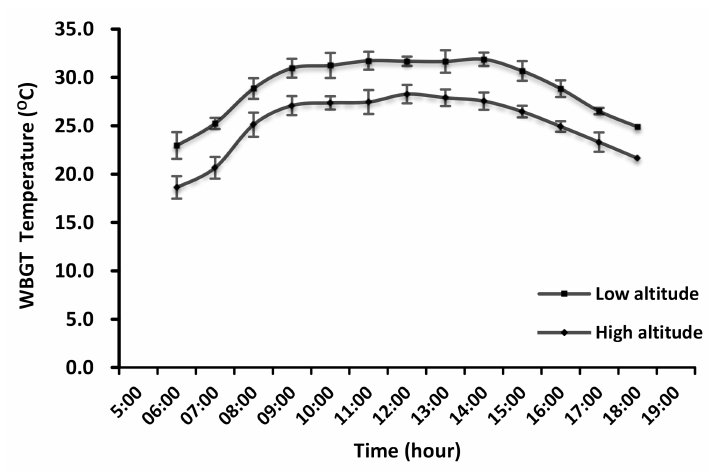
Figure 1. Average WBGT (Wet Bulb Globe Temperature) hourly measurements in a low-altitude area (Karawang Regency) and a high-altitude area (Bogor